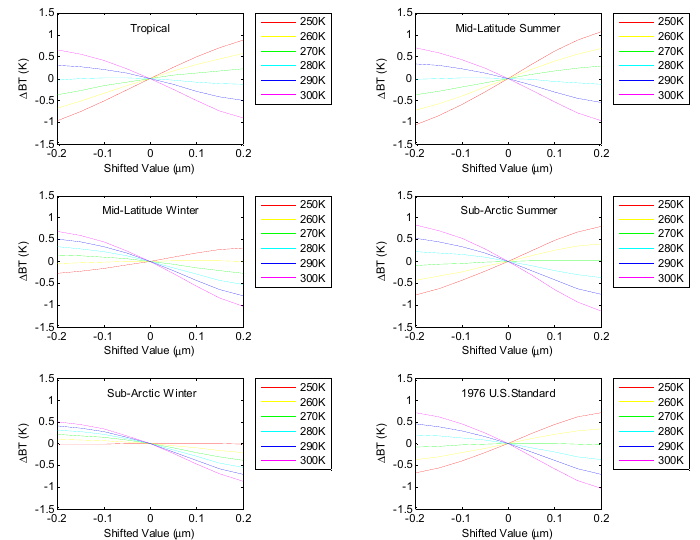
Figure 4. Brightness temperature differences varying with different shifted values of the FY-2G IR2 band SRF on the different conditions of boundary temperatures for six representative atmospheric models.